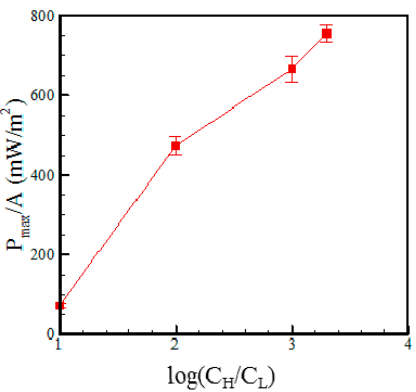
Figure 7. Variation of the maximum power density with concentration ratio given a microchannel length of 1 mm.